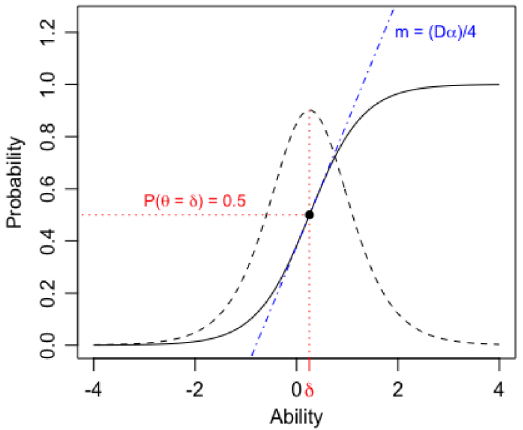
FIG. 7. An example of an item characteristic curve (solid, black) and its associated item information curve (dashed, black) using the 2PL model. When the student ability is equal to the item difficulty ( θ ¼ δ ) the probability of the student answering the questions correctly is 50%; this is also the location of the maximum for the item information curve. The slope ( m ) of the tangent line (dot-dashed, blue) at the 50% mark is propor- tional to the item discrimination ( α ). D is a constant generally set so 1.702 so that the ability axes better lines up with spacings that are equal to a standard deviation of student